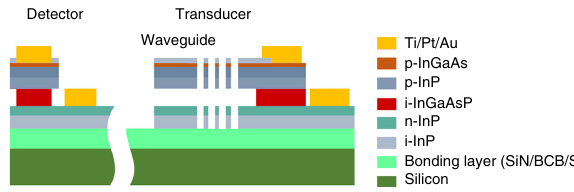
Fig. 2 Schematic cross-section of the layer stack of the device. The detector (left) and the transducer/actuator part